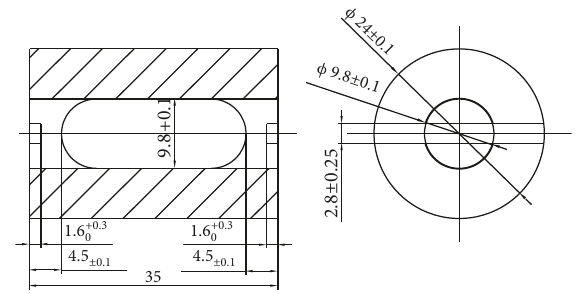
Figure 3: The parameters of the mounting